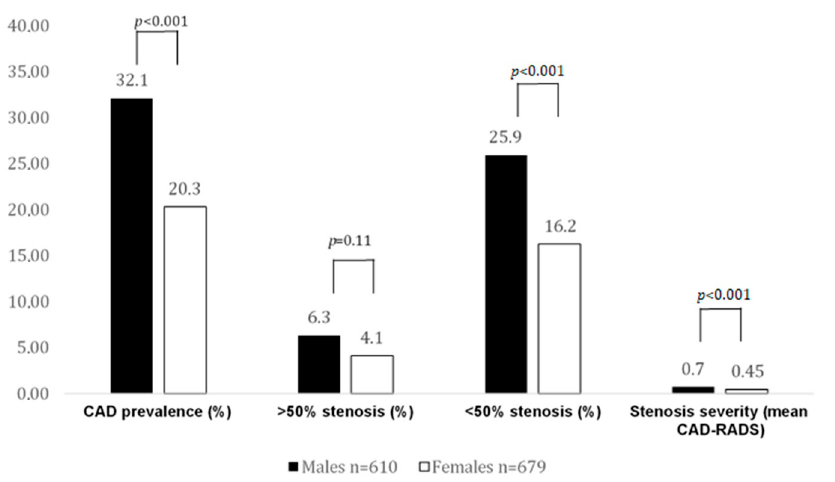
Figure 2. CAD prevalence and stenosis severity by CTA in CACS 0 patients. In this case, 32% of males had atherosclerosis, but significantly fewer females. Obstructive CAD rate was low and not different among sexes. More males (25.9%) with a CACS of 0 had nonobstructive disease.